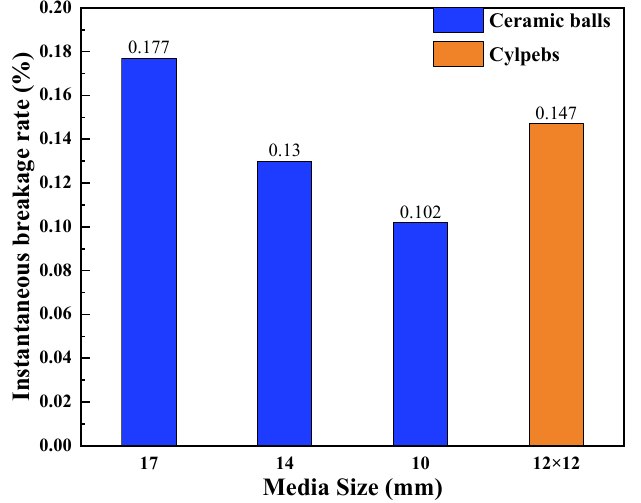
Figure 7. Instantaneous breakage rates of the ground products at the same total number.